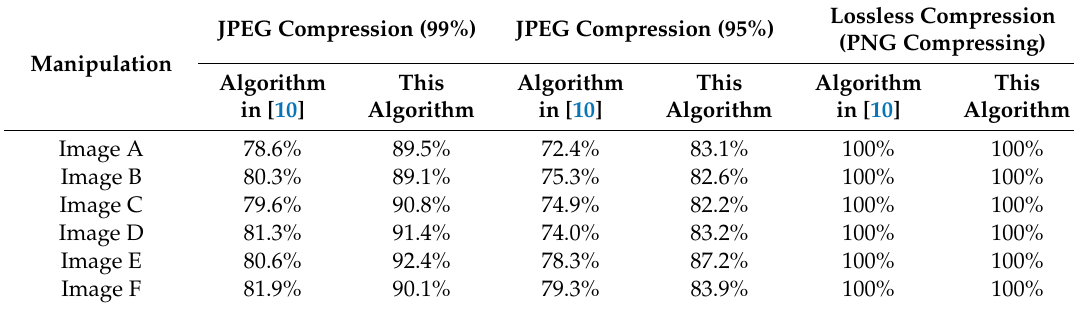
Table 2. The results of the robustness test (Both of the T h are set to